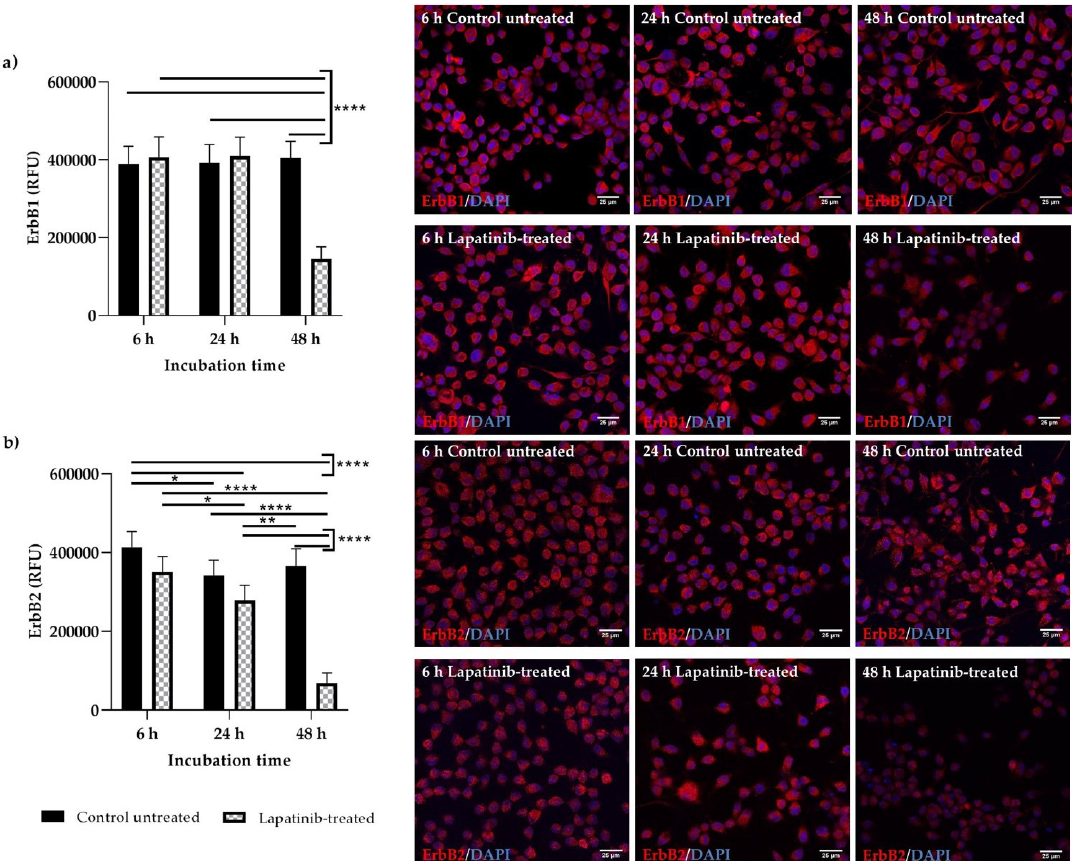
Figure 4. Immunofluorescence staining of ErbB1 and ErbB2 in control untreated and lapatinib-treated Walker 256 rat breast tumour cells at 6, 24 and 48 h incubation. Images shown are overlay images of ( a ) ErbB1 (red)/DAPI (blue) and ( b ) ErbB2 (red)/DAPI (blue). ErbB1 and ErbB2 proteins were expressed in Walker 256 at all time points but with different staining intensities. Corrected total cell fluorescence (CTCF) for ErbB1 and ErbB2 staining intensities were expressed as relative fluorescence units (RFU) as shown on the graphs. Data presented as mean ± S.E.M ( n = 6). Results were compared between control untreated and lapatinib-treated cells at different incubation h. Significant differences between groups are indicated by bars. * for p < 0.05 , ** for p < 0.01 and **** for p < 0.0001 . The staining intensities of control untreated and lapatinib-treated cells were also compared with negative controls (1% BSA and Rabbit IgG) which were stained with secondary antibody only (red) (images not shown). Images are of ×60 original magnification (Scale bar: 25 μm).